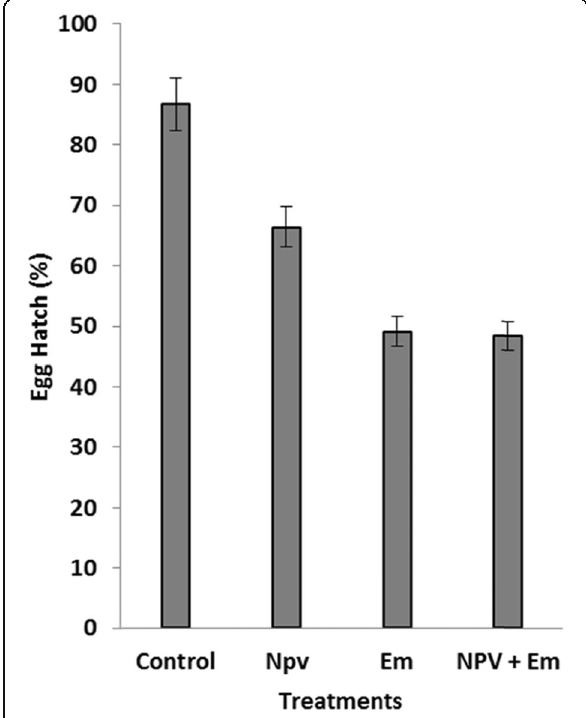
Fig. 9 % Spodoptera littoralis hatched eggs layed by females previously treated as 2nd instar larvae with Spli MNPV Em 0.05 ppm, Em 1 × 10 4 BIPs, and Em 0.05 ppm + SpliMNPV 1 × 10 4